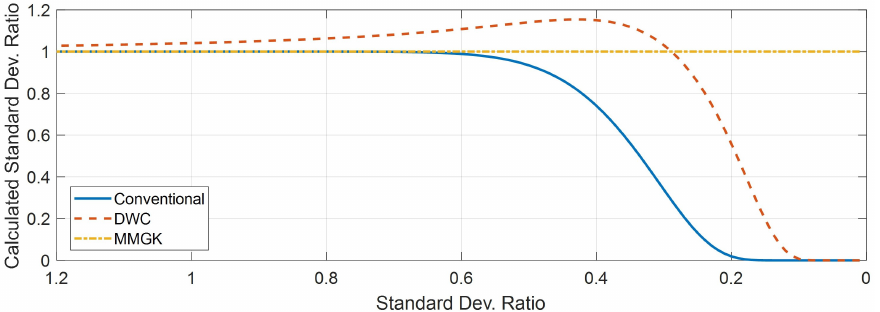
Figure 1. Comparison of the variances of the various kernels, the conventional kernel, MMGK, and